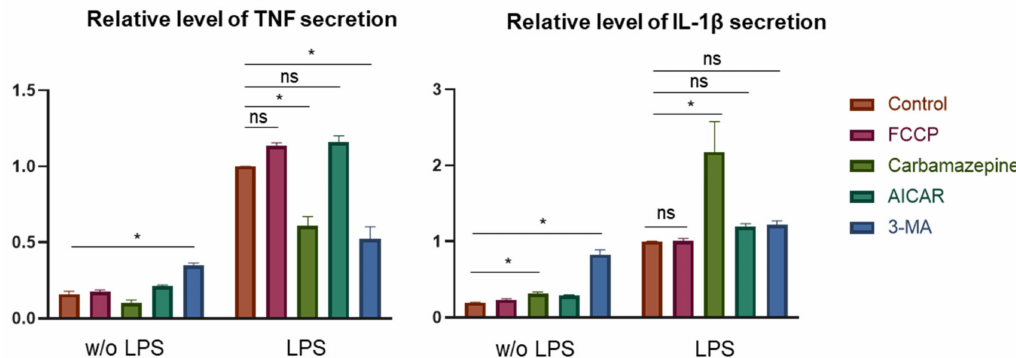
Figure 10. The e ff ect of mitophagy modulators on the ability of human monocytes being activated in response to LPS. Monocytes were isolated from patients using magnetic CD14 + separation. Isolated cells were placed into 24-well plates (106 cells per 1ml of serum free X-VIVO media) with or without mitophagy modulators and had been incubating with or without 1 µ g / mL of LPS for 24h. Then secretion level of TNF and IL-1 β was measured using ELISA. The values of cytokine secretion by LPS-treated monocytes were taken as 1. Statistical analysis of the results of three independent experiments was carried out using the IBM SPSS Statistics 21 software package. Significance p < 0.05 is marked with an asterisk and estimates the di ff erence between Control and added mitophagy modulators according to the results of t-test for paired samples. Ns – no significance, p > 0.05. Mitophagy modulators: FCCP, Carbonyl cyanide-4-(trifluoromethoxy) phenylhydrazone, 10-7 M; Carbamazepine, 8 µ g / mL;